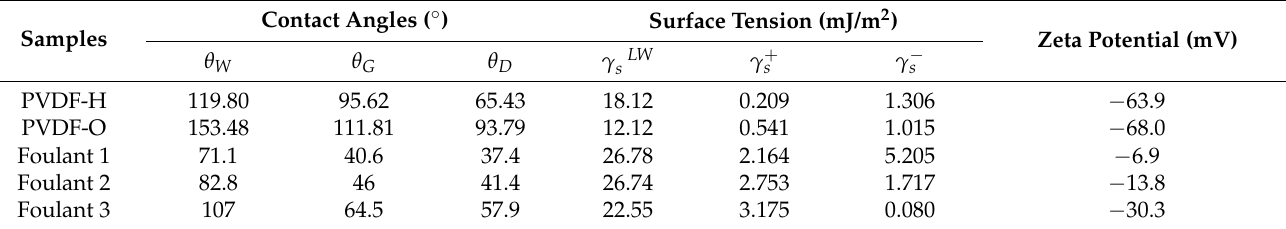
Table 6. Contact angle and surface tension of membranes and foulants.